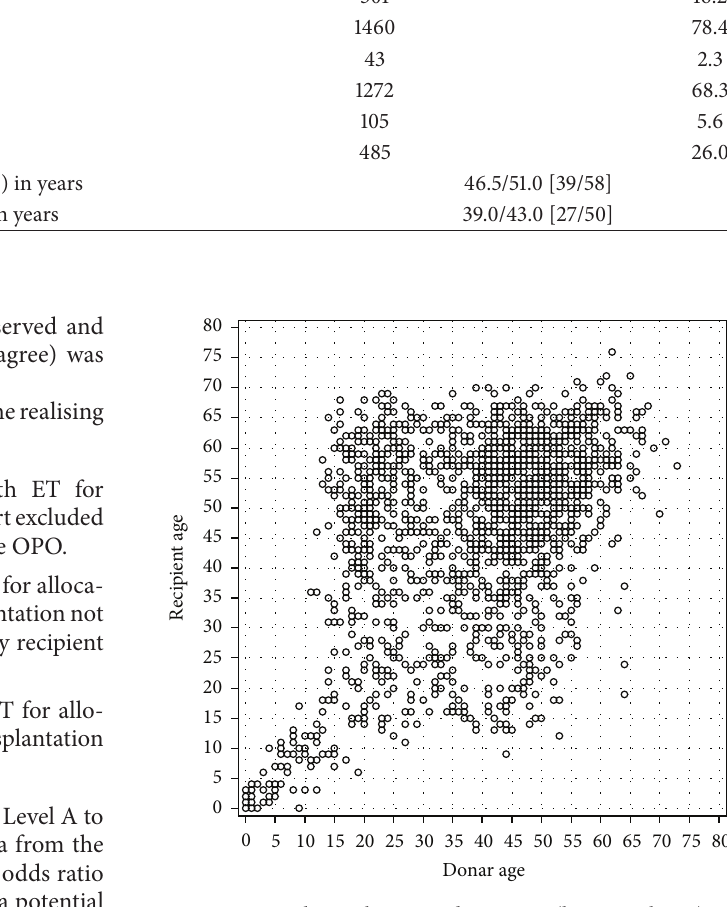
Figure 2: Correlation between donor age (horizontal-axis) and recipient age